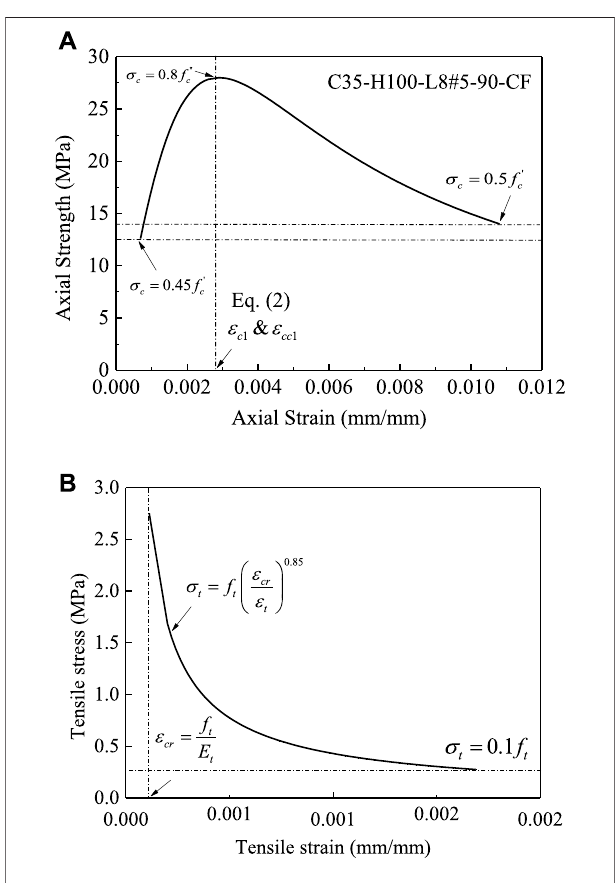
FIGURE 4 | Modeling the response of GFRP-con fi ned concrete: (A) Tests under compression loading; (B) Tests under tension loading.